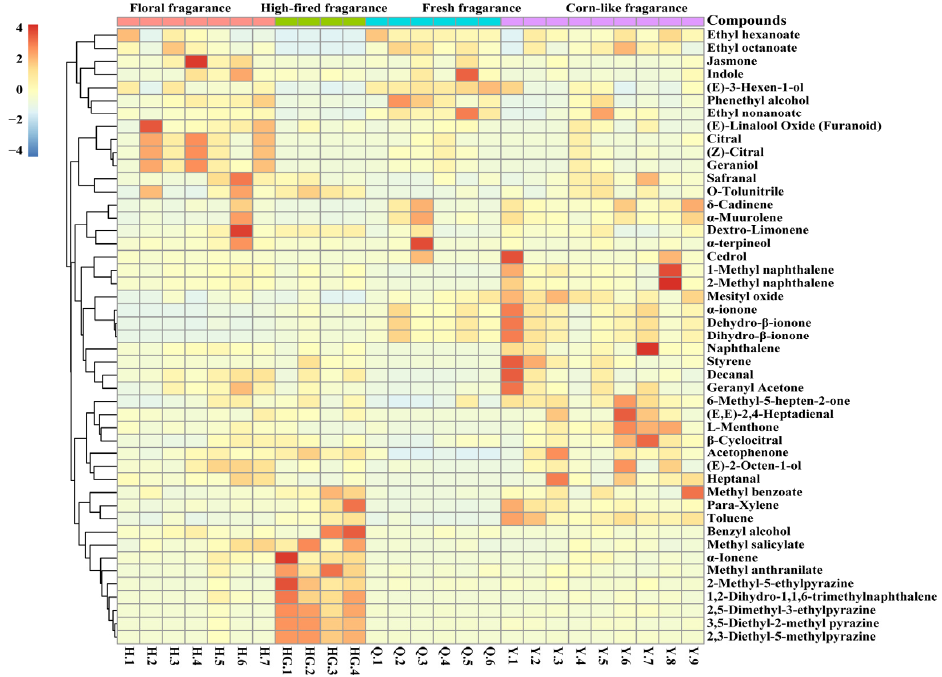
Figure 3. Heatmap of the discriminatory aroma compounds in the different aroma types of yellow